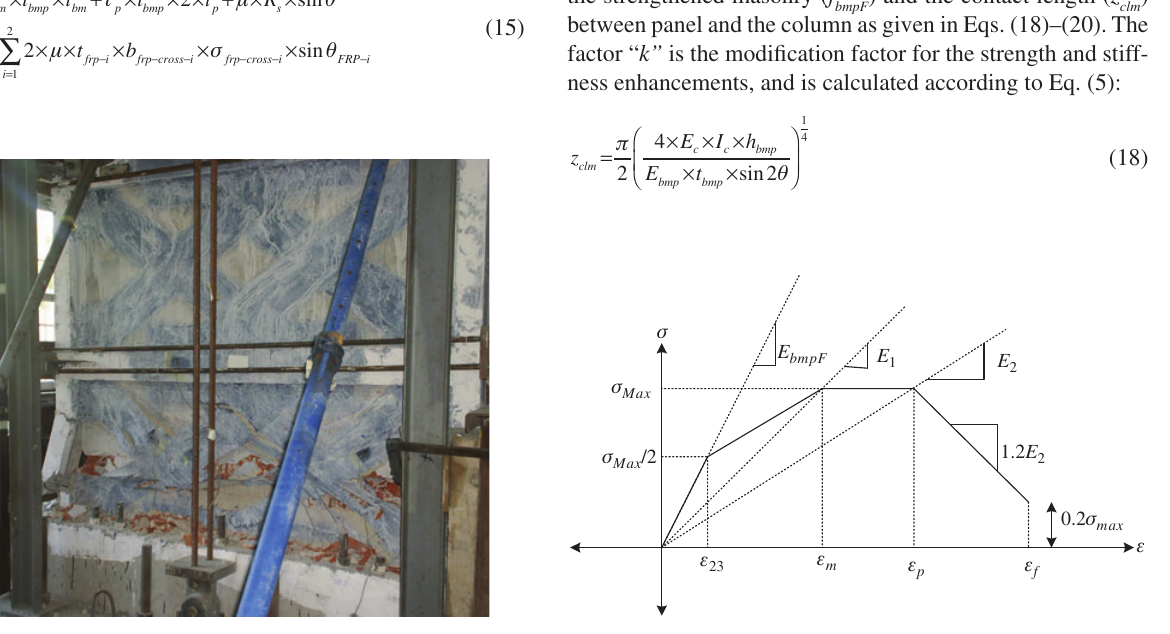
Figure 16 Axial stress-axial strain relationship of the equivalent compression strut.